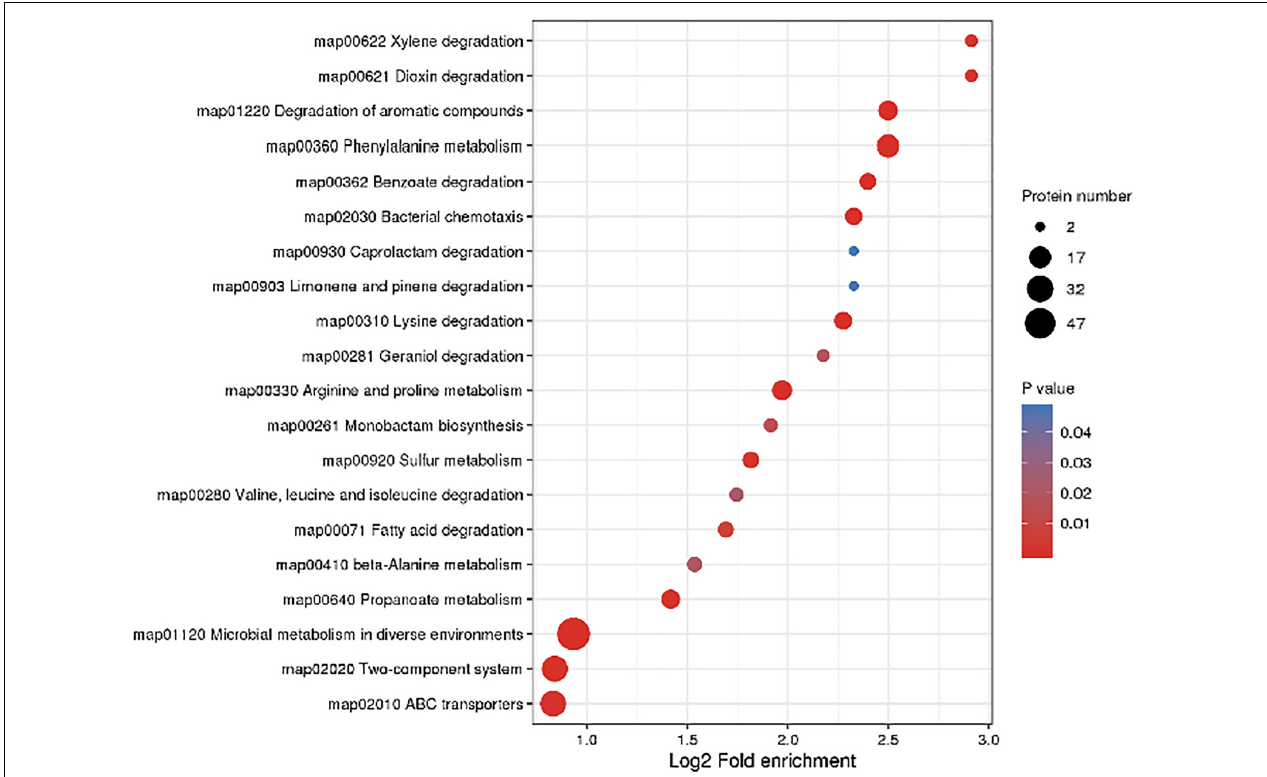
FIGURE 3 | Significantly enriched KEGG